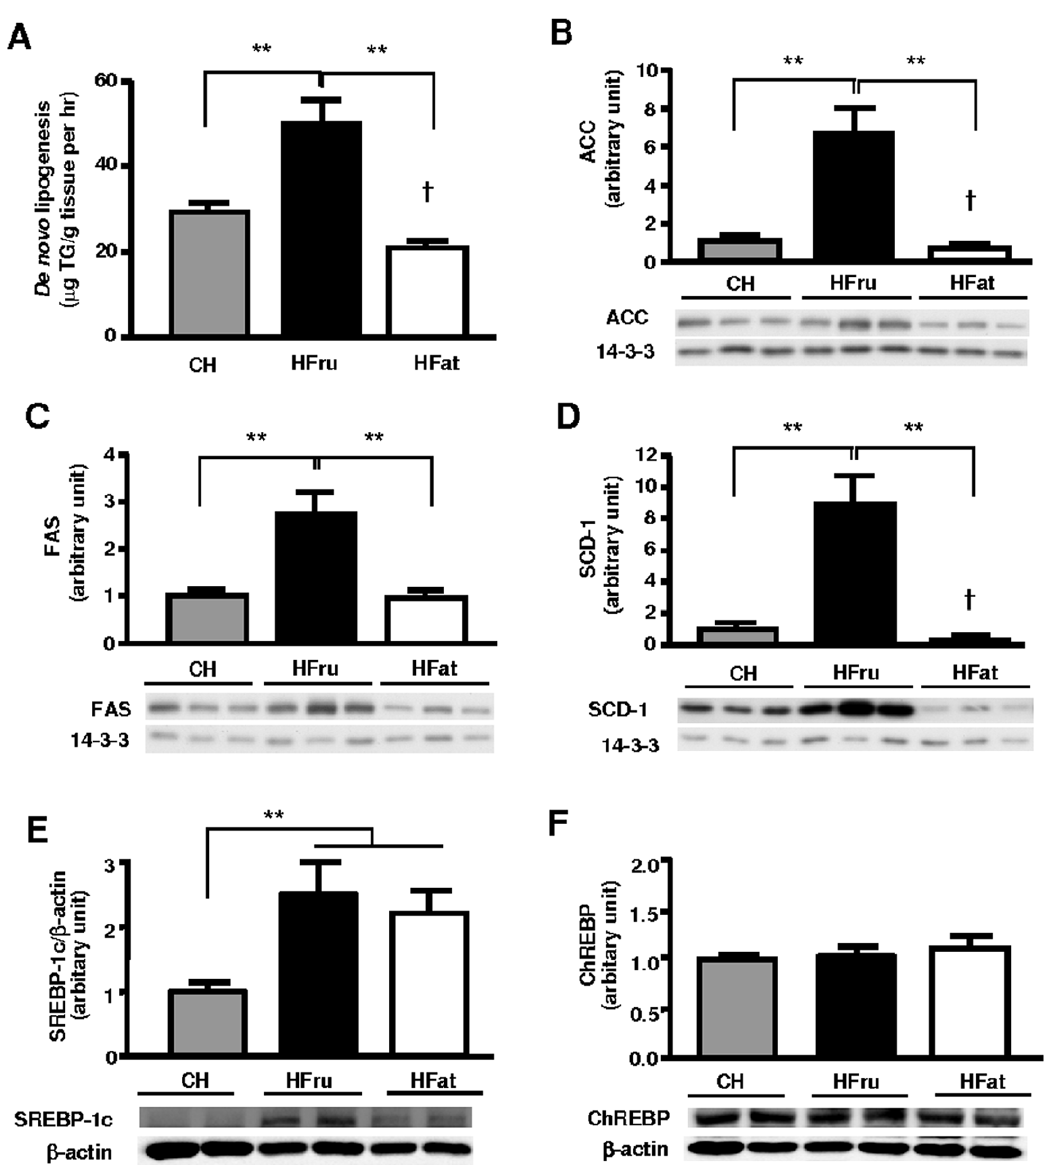
Figure 3. Effects of HFru and HFat on hepatic DNL, lipogenic protein levels and protein expression of SREBP-1c and ChREBP. After one week of HFru or HFat feeding, ( A ) hepatic DNL was measured by the incorporation of [ 3 H]-H 2 O into hepatic triglyceride (n=8/group). Protein levels of lipogenic enzymes ACC ( B ), FAS ( C ) and SCD-1 ( D ) were determined by immunoblots. Each lane represents a single mouse. Densitometry data are mean 6 SE of 6 mice per group. Protein expressions of the lipogenic transcription factors SREBP-1c ( A ) and ChREBP ( B ) were determined by western blotting. Data are mean 6 SE relative to CH-fed mice of 6 mice per group. * p , 0.05, ** p , 0.01. { p , 0.05 vs CH.